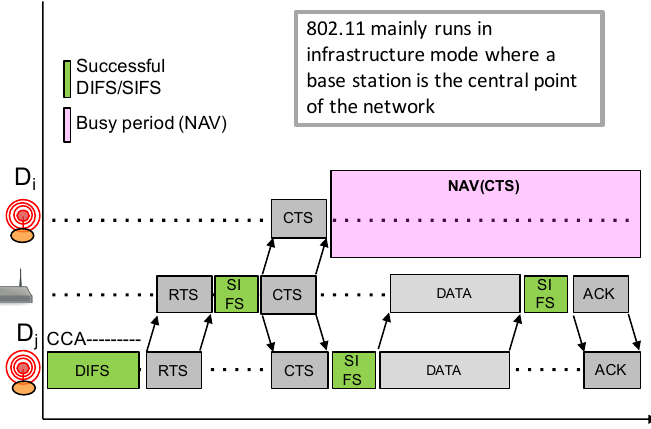
Figure 11. IEEE 802.11 CSMA/CA RTS/CTS.